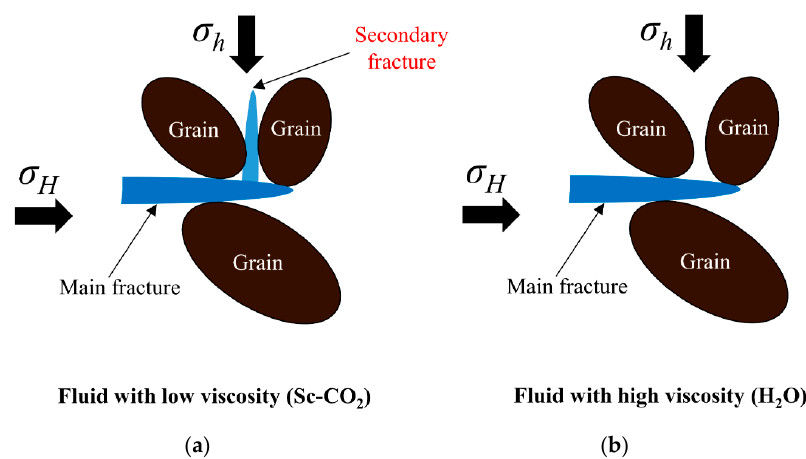
Figure 14. Illustration of fracture propagation type with different viscosity fluid. ( a ) Low-viscosity fluid-driven fracture propagation. ( b ) High-viscosity fluid-driven fracture propagation. Low-viscosity fluid more easily penetrates smaller pore throats and creates secondary fracture or fractures with larger